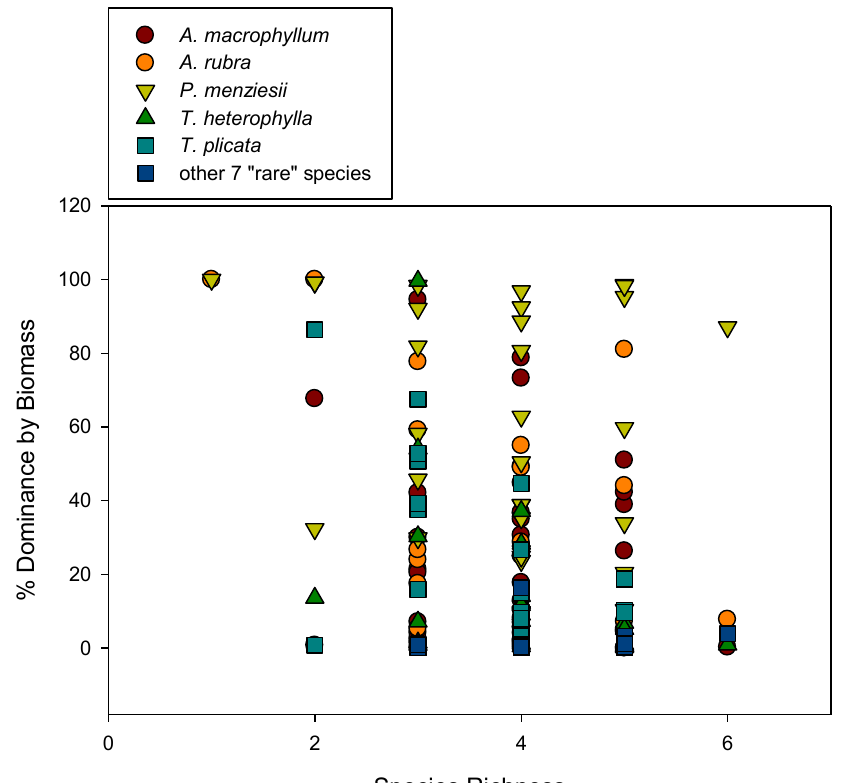
Figure 5 . Percent dominance by biomass of individual species by species richness. Most species were represented evenly across richness